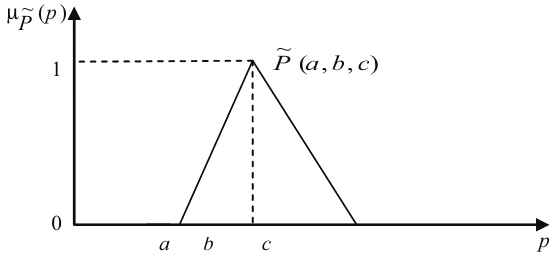
figure 1. Distribution of a triangular fuzzy number P